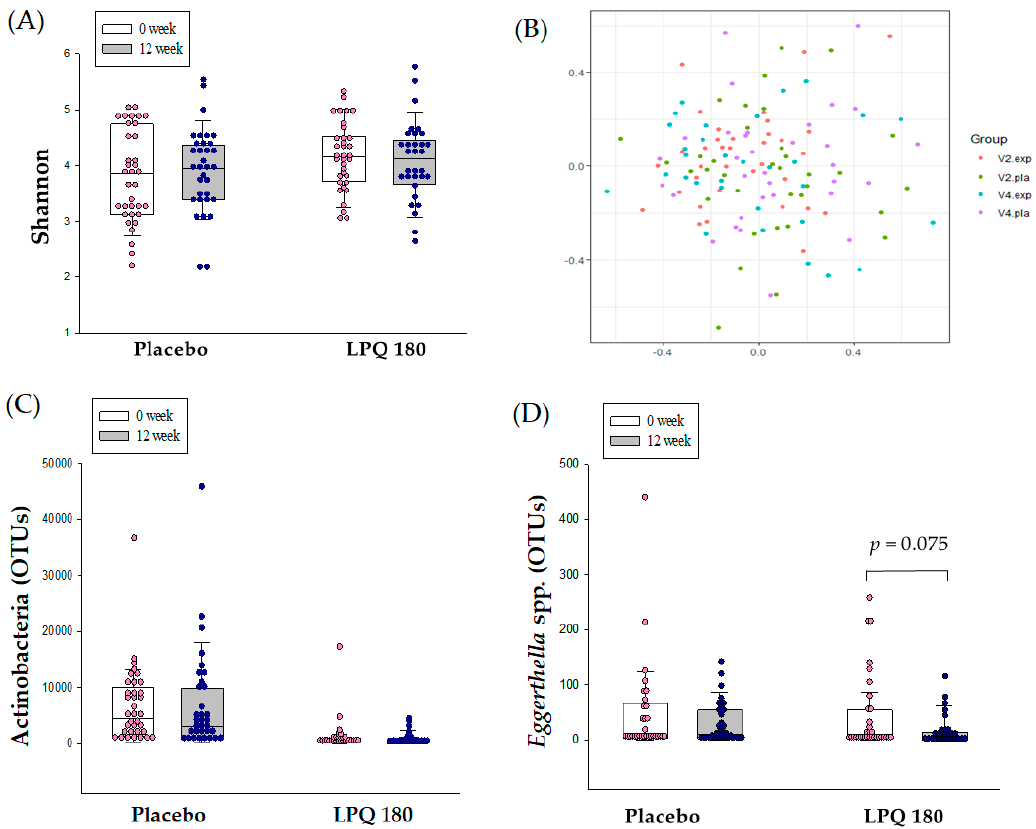
Figure 2. Changes in the intestinal microflora: ( A ) intestinal flora diversity represented by Shannon index (Alpha-diversity); ( B ) distance analysis between microbial communities by group (NMDS: Non-metric Multidimensional Scaling); ( C ) 12-week change in the placebo and LPQ180 groups of Actinobacteria, the upper level of Eggerthella spp.; and ( D ) microbial community significantly changing between Week 0 and Week 12 at genus level ( Eggerthella spp.).